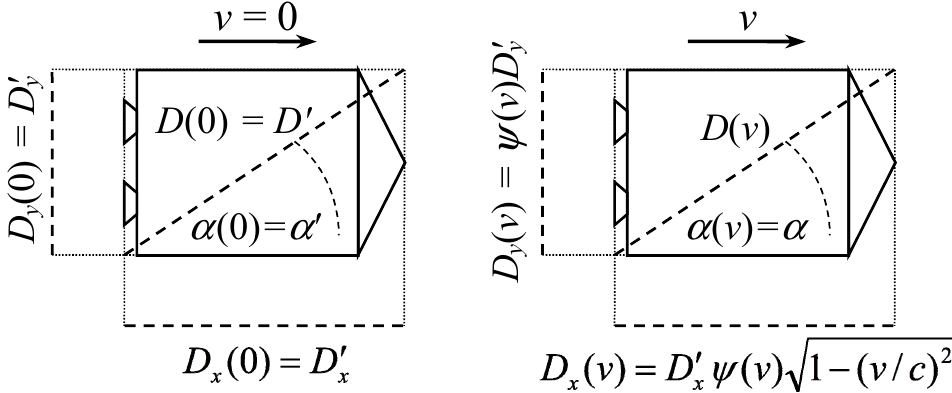
Figure 5. Body dimensions in STE observed by a motionless observer in relation to ether.